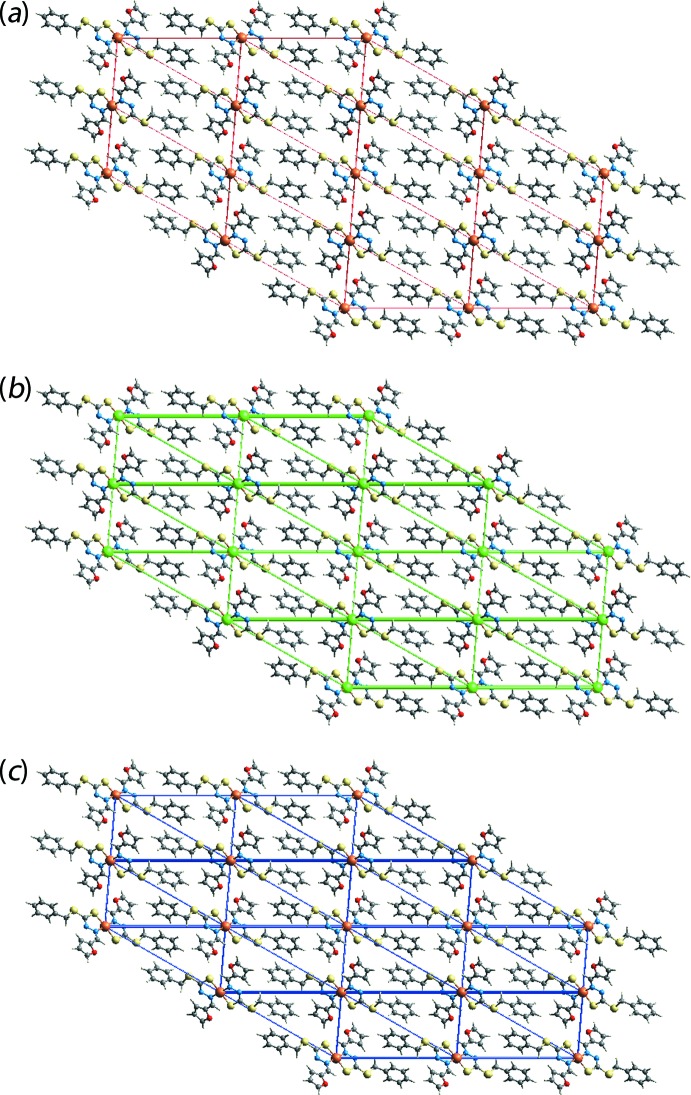
The energy frameworks viewed down the b-axis direction comprising (a) electrostatic potential force, (b) dispersion force and (c) total energy for a cluster about a reference mol­ecule of (I). The energy frameworks were adjusted to the same scale factor of 50 with a cut-off value of 3 kJ mol−1 within 2 × 2 × 2 unit cells.